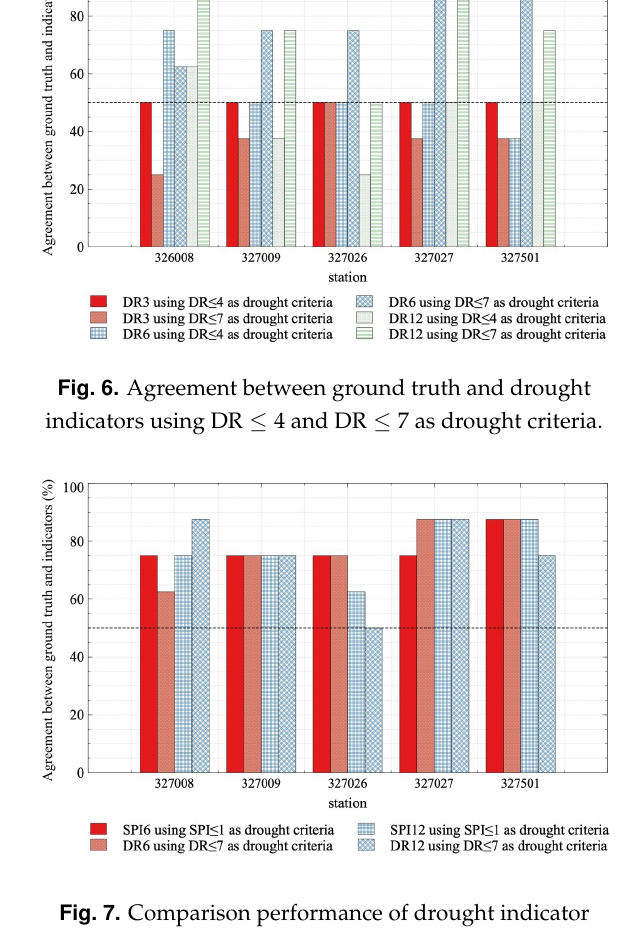
Fig. 7. Comparison performance of drought indicator between SPI and